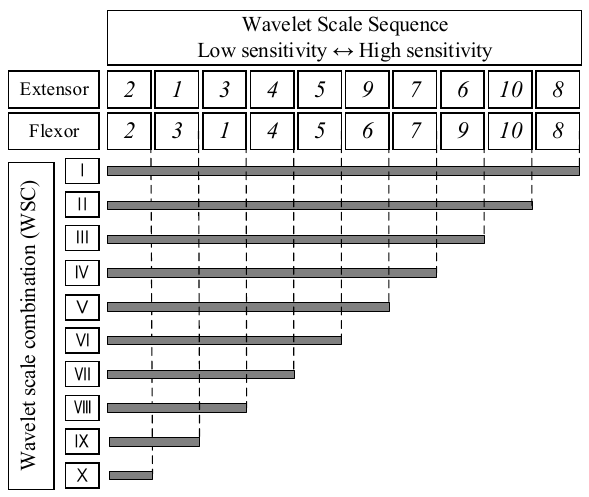
Figure 6. Sequence combination of wavelet scales based on the sensitivity value.